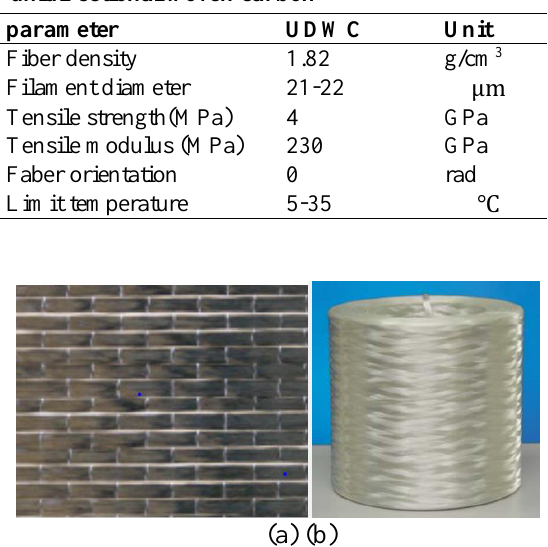
Fig. 1. (a) Unidirectional carbon fiber (b) Fiber